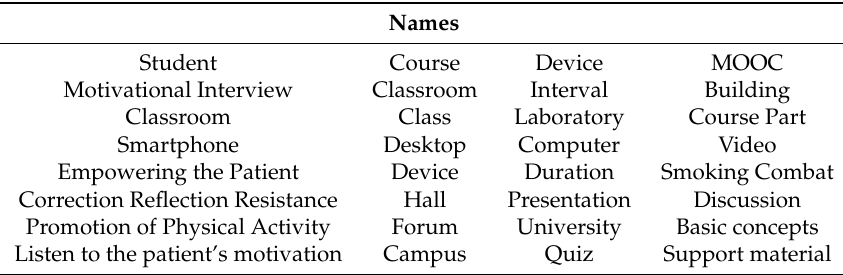
Table 2. Application Lexicon.